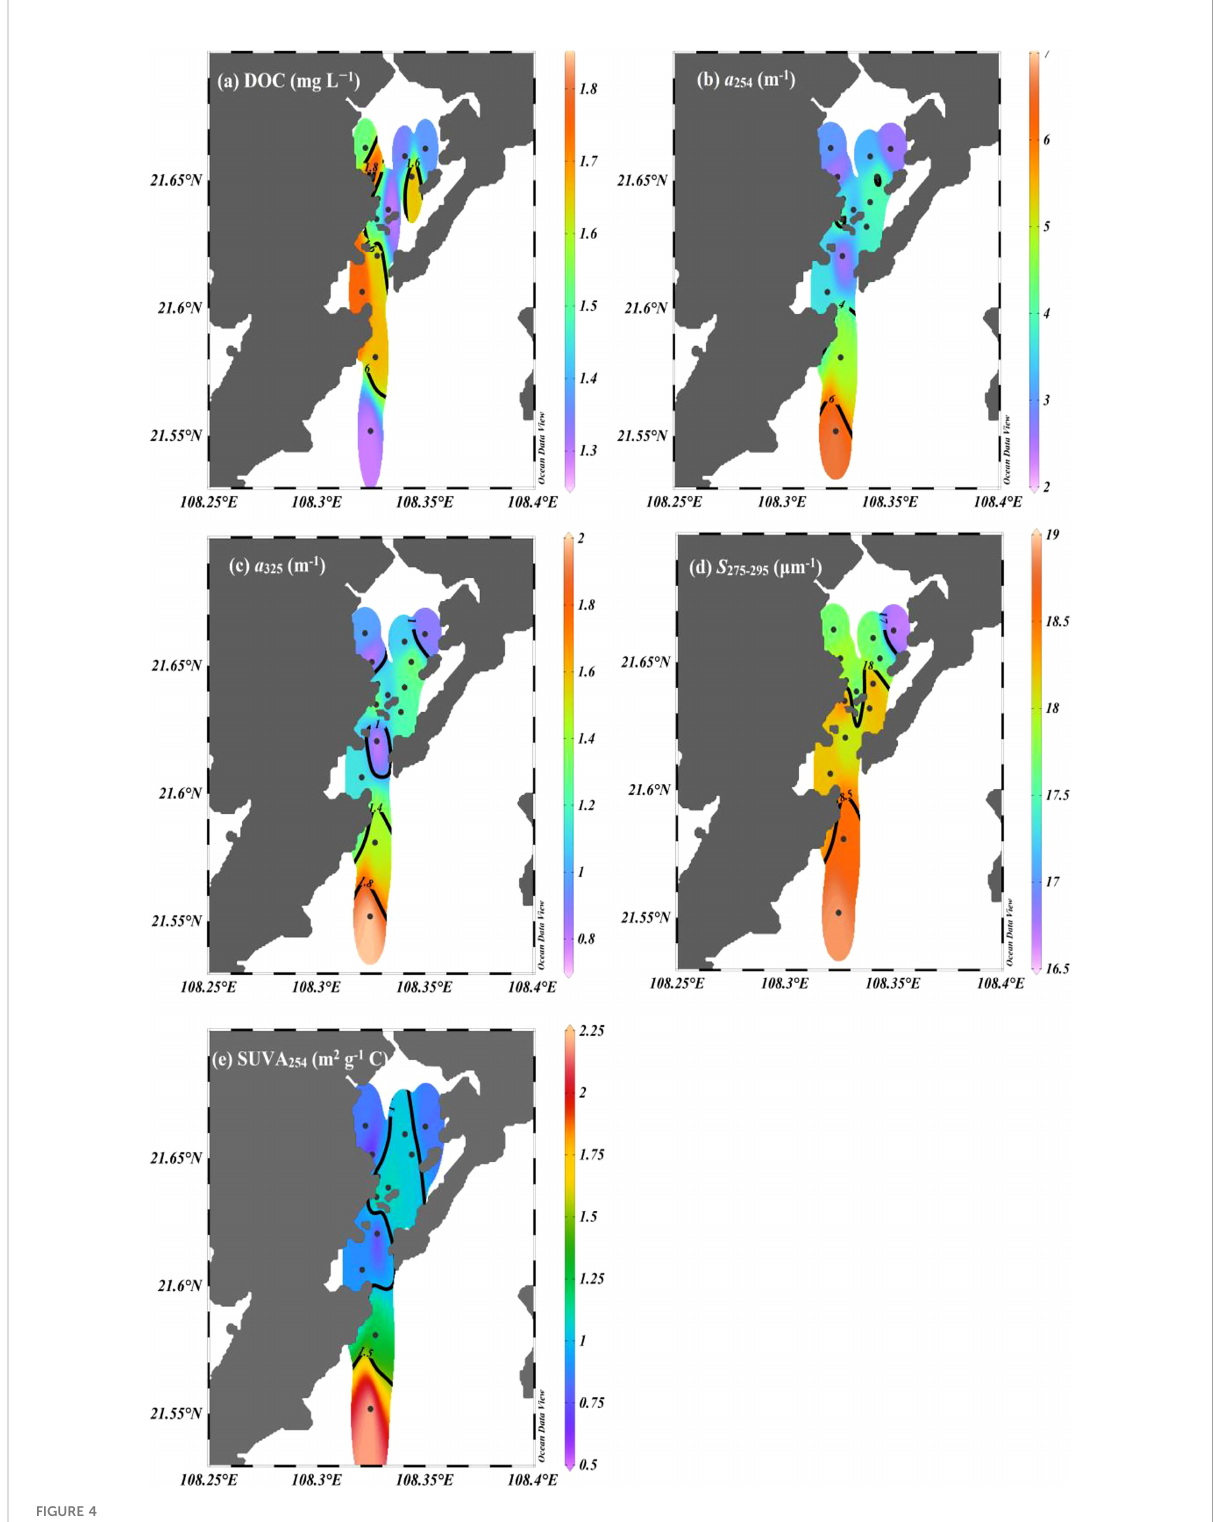
FIGURE 4 Spatial distributions of (A) DOC (mg L − 1 ), (B) a 254 (m − 1 ), (C) a 325 (m − 1 ), (D) S 275 − 295 ( m m − 1 ), and (E) SUVA 254 (m 2 g − 1 C) in Xi Bay. Black dots represent the sampling